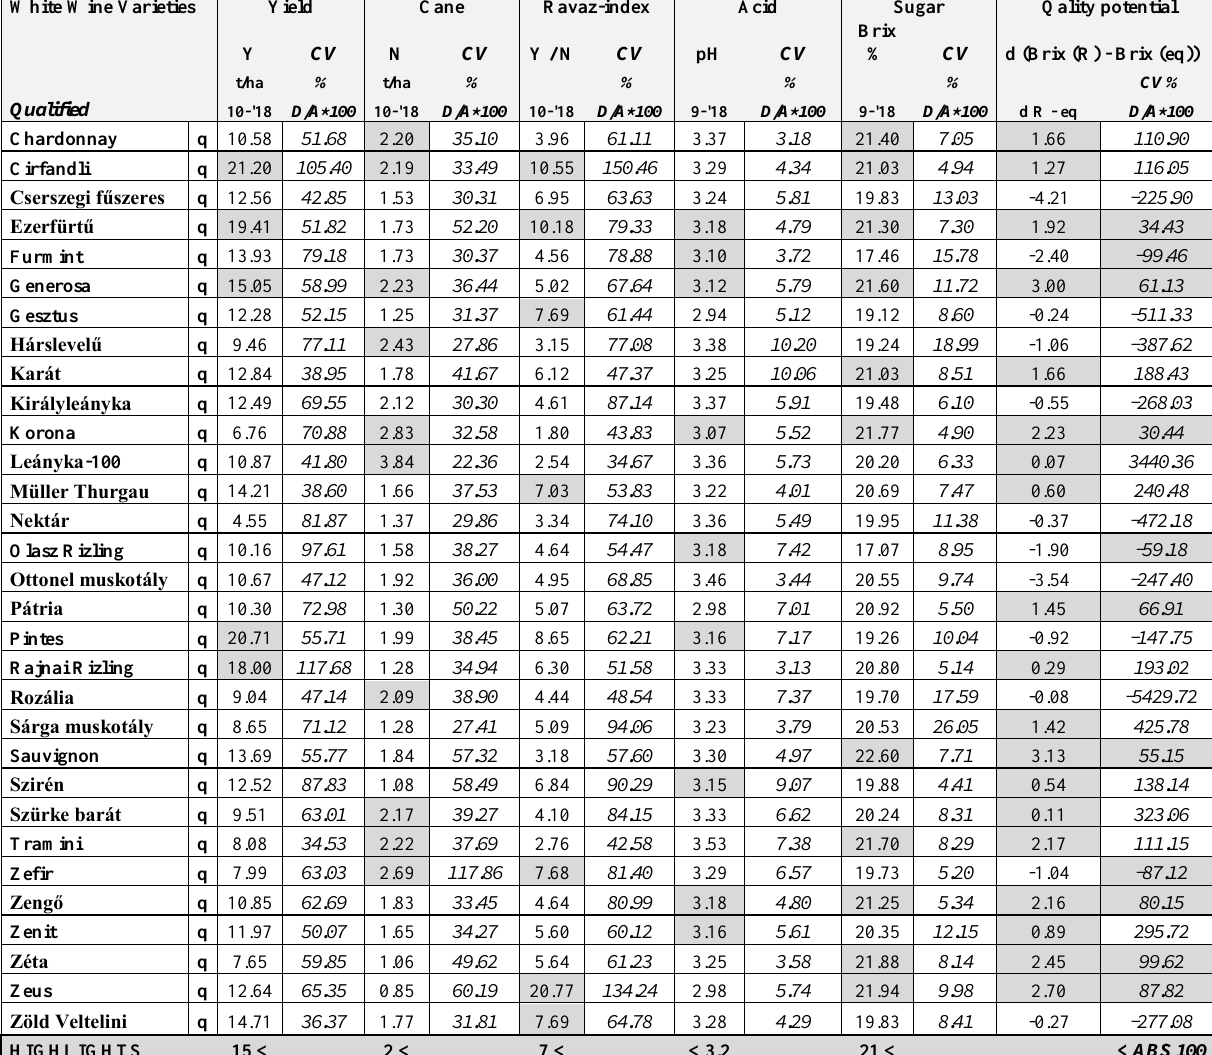
Table 2. Production and flexibility data of qualified Vitis vinifera (L.) white wine grape varieties (Pallag, 2010-2018). White Wine